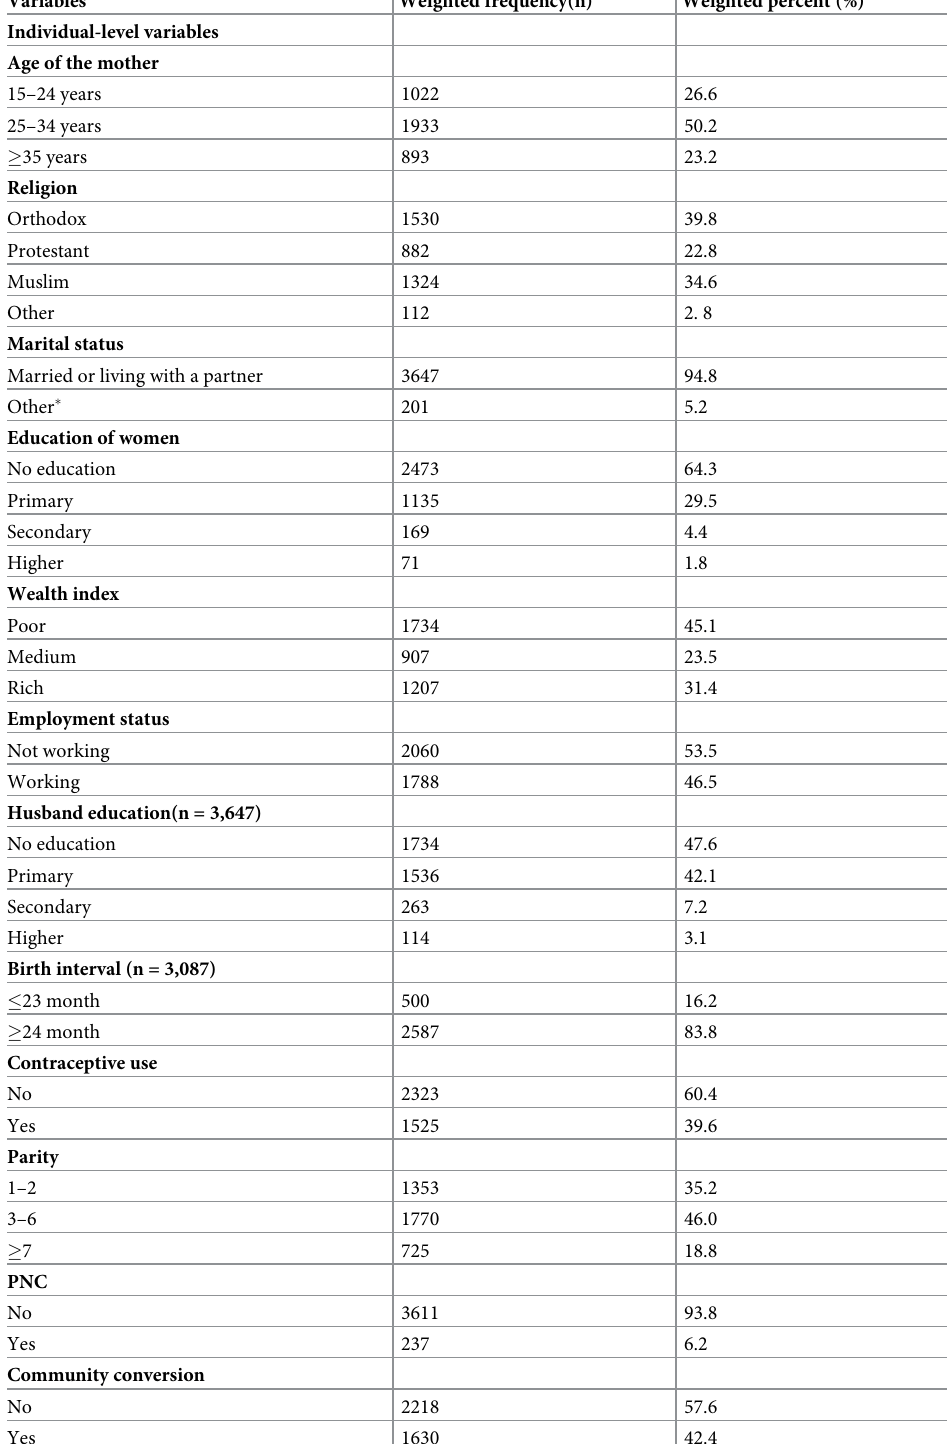
Table 1. Underweight among lactating mothers by background individual and community-level characteristics in Ethiopia, 2016 (n =